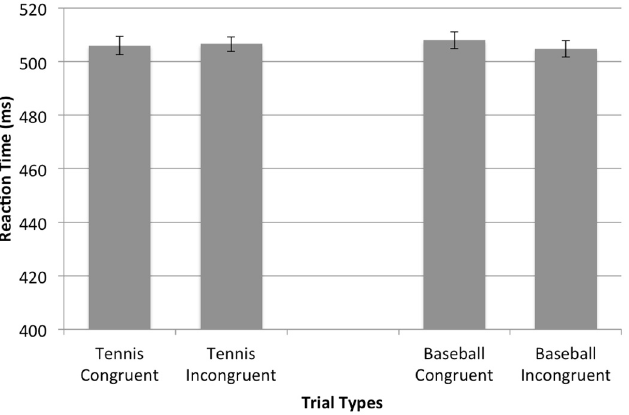
Fig 4. Novice Reaction Times. Mean reaction times for novice tennis players across both congruent and incongruent trials for tennis and baseball. Error bars represent standard error.